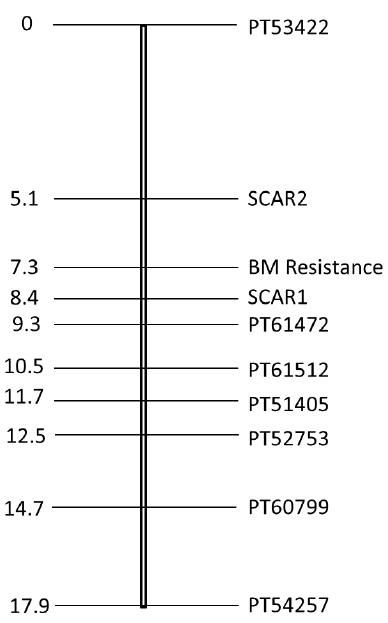
Figure 2. Genetic mapping of the RBM1 locus on the linkage group 7. The genetic distance (cM) for each molecular marker is indicated on the left side of chromosome. The map is drawn to